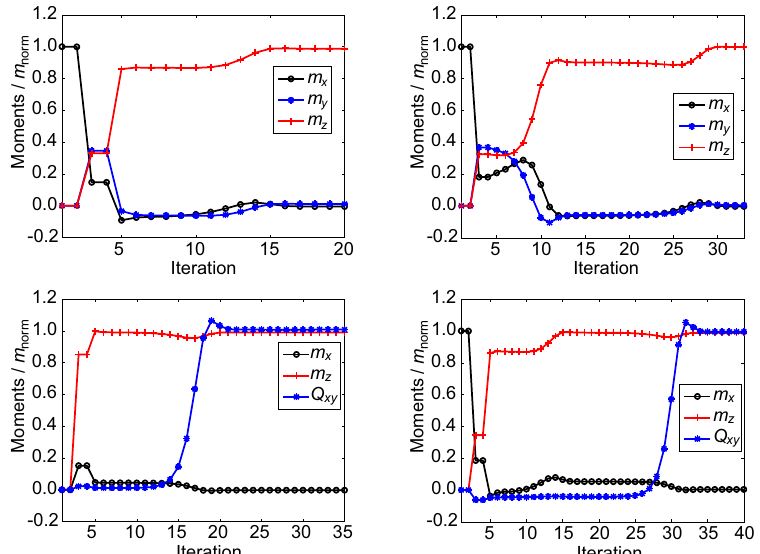
Figure 7. Estimation of planetary moments neglecting the interaction with the solar wind and using synthetic data. The reconstructions shown in the upper panels take only a dipole moment into account. These two results consider a different spacecraft trajectory, with a trajectory closer to the planet corresponding to the left figure. All reconstructions presented use the same dipole moment for calculating the synthetic spacecraft data. However, in the lower panels, an additional quadrupole component was introduced. The reconstructions in the lower panels use a different choice of the initial parameters for the